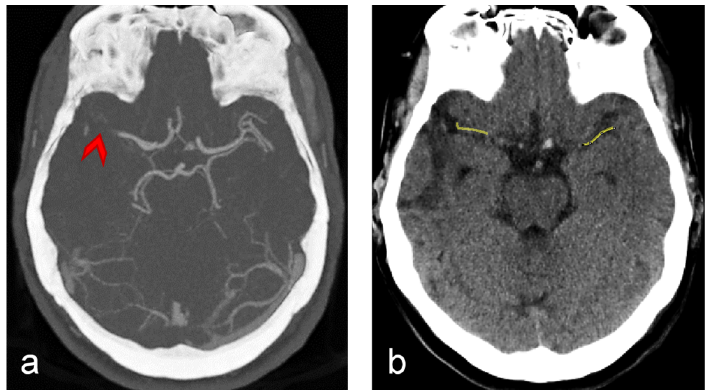
Figure 2. Representative brain CT images of an ischemic stroke patient in a slice with the middle cerebral (MCA) artery: ( a ) CT angiograph (CTA) image and ( b ) non-contrasted CT (NCT) image of the same slice. Red arrow in the CTA image points to the occlusion (thrombus), while yellow lines in the NCT image correspond to the lines along which HU values were measured in the occluded site (left) and in the symmetrical positioned non-occluded site (right).